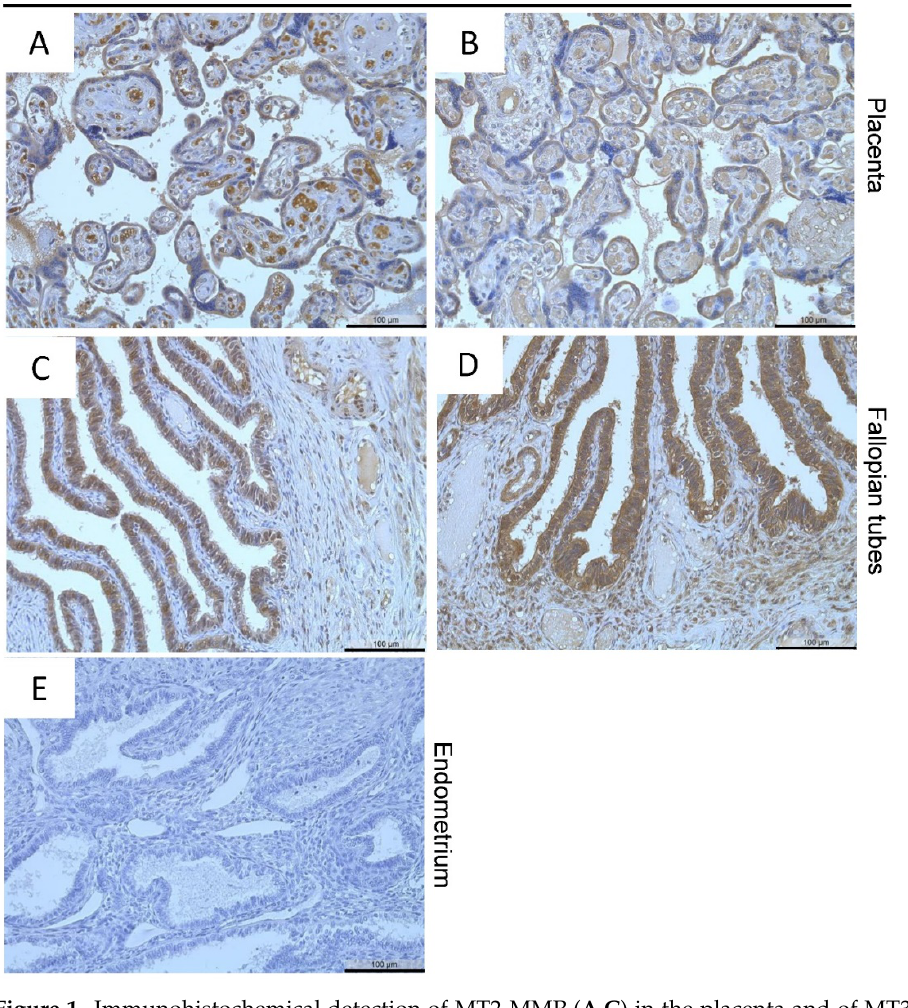
Figure 1. Immunohistochemical detection of MT2-MMP ( A , C ) in the placenta and of MT3-MMP ( B , D ) in the fallopian tubes (positive controls), No staining was found in the negative control. Counterstaining was performed with hematoxylin. Magnification ( A – E ) 20×, scale bars 100 μm.